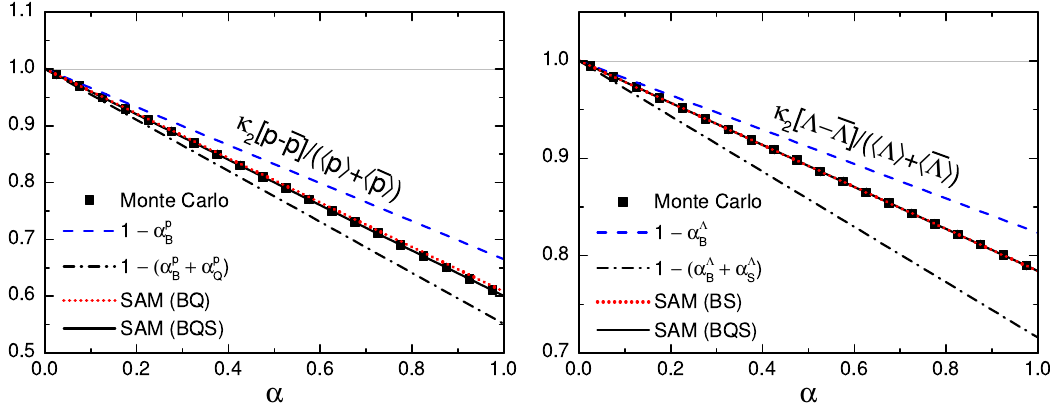
Figure 5 . Acceptance (cid:11) dependence of net-particle variance normalized by Skellam distribution baseline for net-proton ( left panel ) and net-(cid:3) ( right panel ) (cid:13)uctuations, as calculated in the hadron resonance gas model using canonical ensemble Monte Carlo sampler (symbols) and analytically in the framework of the subensemble acceptance method (SAM) with three conserved charges (solid black lines), two conserved charges (dotted red lines), one conserved charge (dashed blue lines), as well as using approximate relations (3.20) and (3.21) for two conserved charges (dash-dotted black lines). The Monte Carlo sample is the same as in (cid:12)gure 4. Figure 5 depicts the (cid:11) -dependence of the second order net-proton (left panel) and net- (cid:3) (right panel) cumulants scaled by the grand canonical Skellam distribution baselines. Calculations include feeddown from all strong and electromagnetic decays. The symbols depict the results of Monte Carlo sampling. The Monte Carlo calculations agree with the exact SAM calculation in a presence of three canonically conserved charges [eq. (3.13)], shown in (cid:12)gure 5 by the solid